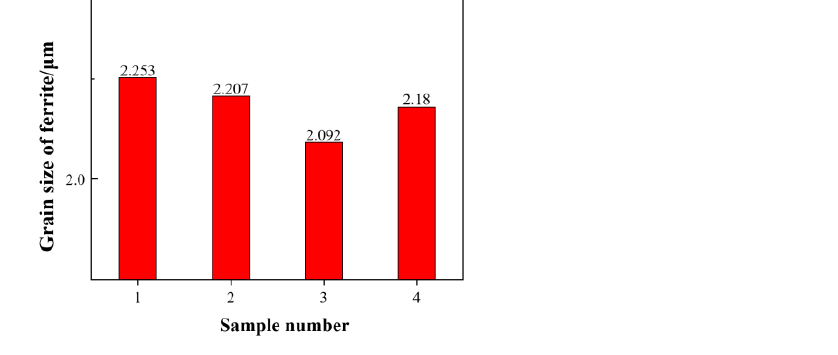
Figure 3. Average grain size of FeCrAl ODS steel samples with different Zr contents.